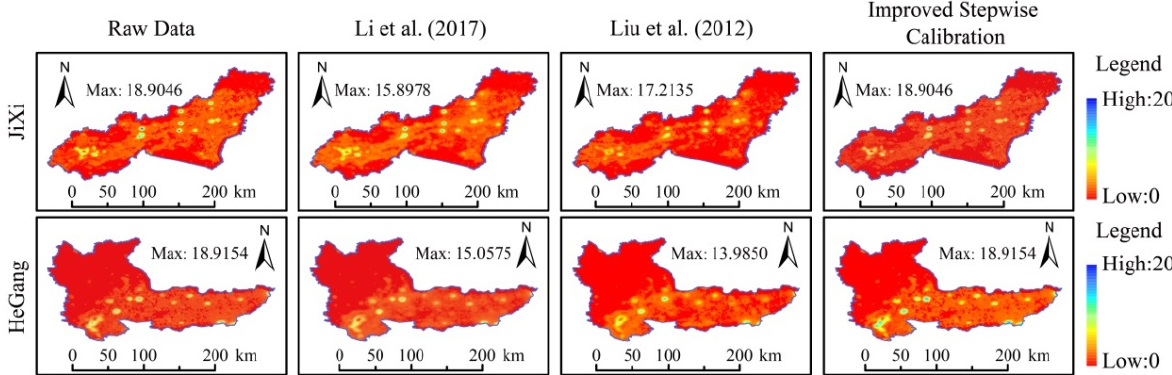
Figure 9. Standard deviation maps of three different calibration methods in Jixi and Hegang cities [5,21].